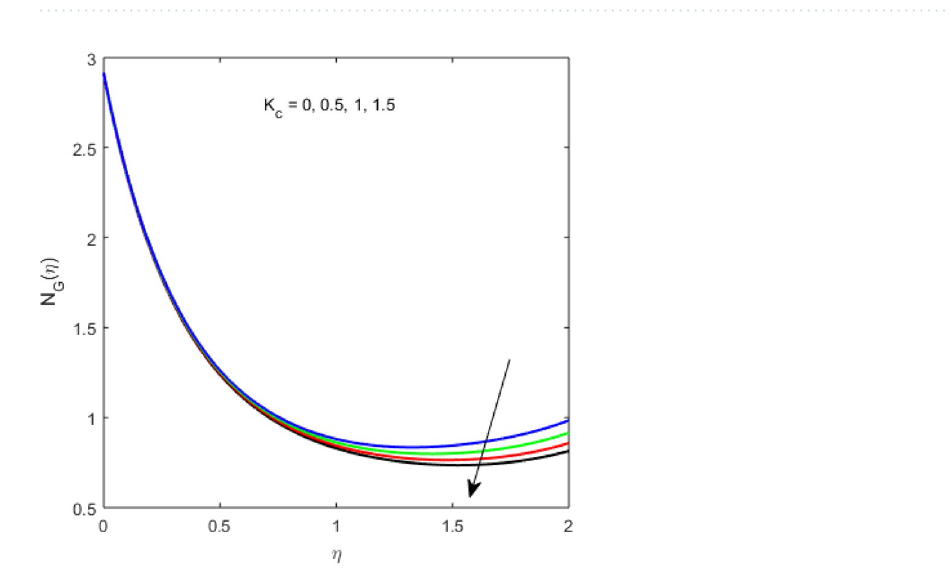
Figure 14. Sherwood number ( Re r ) − 1 / 2 Sh versus K vs for varing N b .